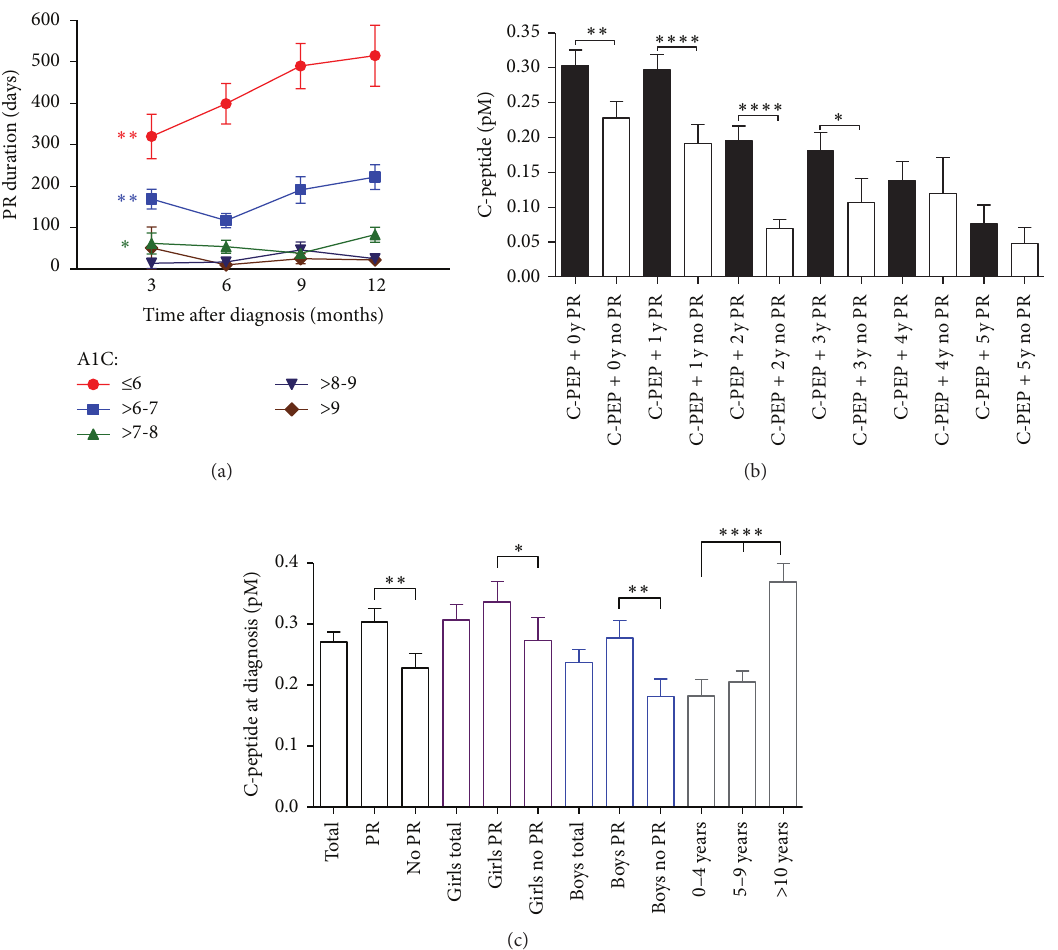
Figure 2: Influence of early A1C levels on PR duration and characteristics of C-peptide levels among PR, age, and gender subgroups. (a) Graph showing negative correlation between A1C levels (subgroups indicated) at 3-, 6-, 9-, and 12-month follow-up and PR duration. (b) C-peptide levels were higher in patients entering PR when evaluated at diagnosis and after 1, 2, and 3 years. (c) Differences in C-peptide levels among PR, gender, and age subgroups. All bars were shown with SEM. ∗ 𝑃 < 0.05 , ∗∗ 𝑃 < 0.01 , and ∗∗∗∗ 𝑃 < 0.0001 compared with indicated